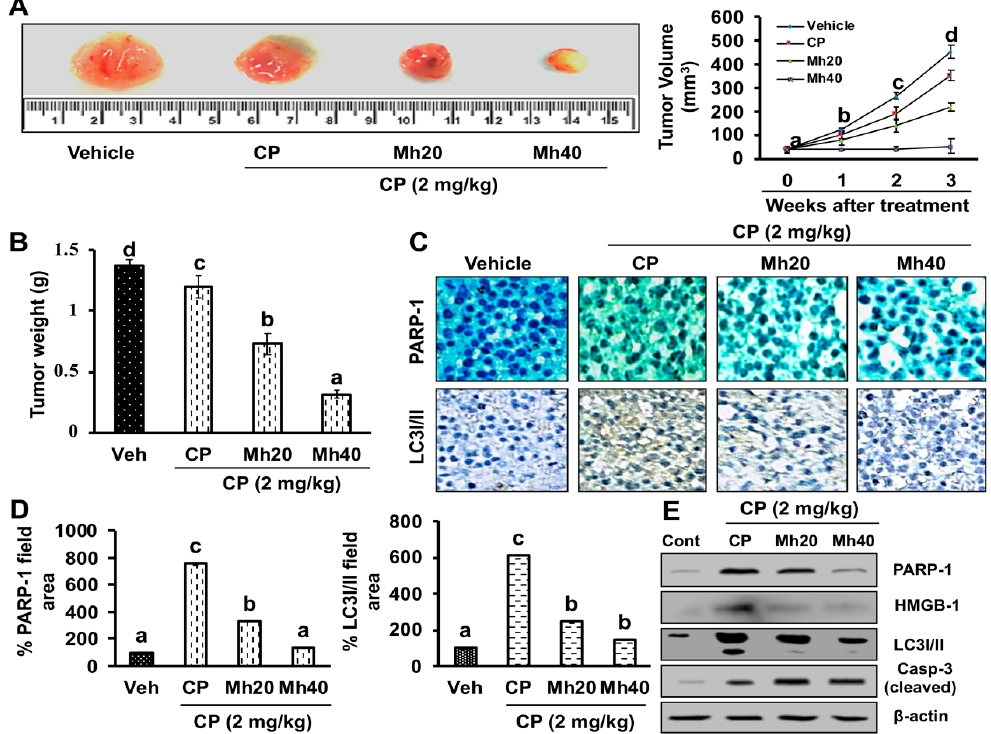
Figure 10. CP-Mh inhibits the growth of human hepatocellular carcinoma (HCC) xenograft in vivo. ( A ) Representative images of HepG2 xenograft nude mice display regression of tumor volume after treatment with CP-Mh in comparison to CP-treated and untreated groups. ( B ) Dissected tumors from vehicle CP and CP-Mh-treated xenograft mice; change in tumor weight observed after initiating the treatment. ( C ) The expression of PARP-1 and LC3I/II were determined by immunohistochemistry, ( D ) percentage of IHC stained proteins (PARP-1 and LC3I/II) were quantified by ImageJ. ( E ) Representative blots showing the total PARP-1, HMGB-1, LC3-I/II and Casp-3 in the vehicle, CP and CP-Mh-treated xenograft tissues (scale bar = 0.1 mm). The data are represented as mean standard deviation of three independent experiments ( n = 3). Values with different letters (a–d) differ significantly from each other ( p < 0.05).